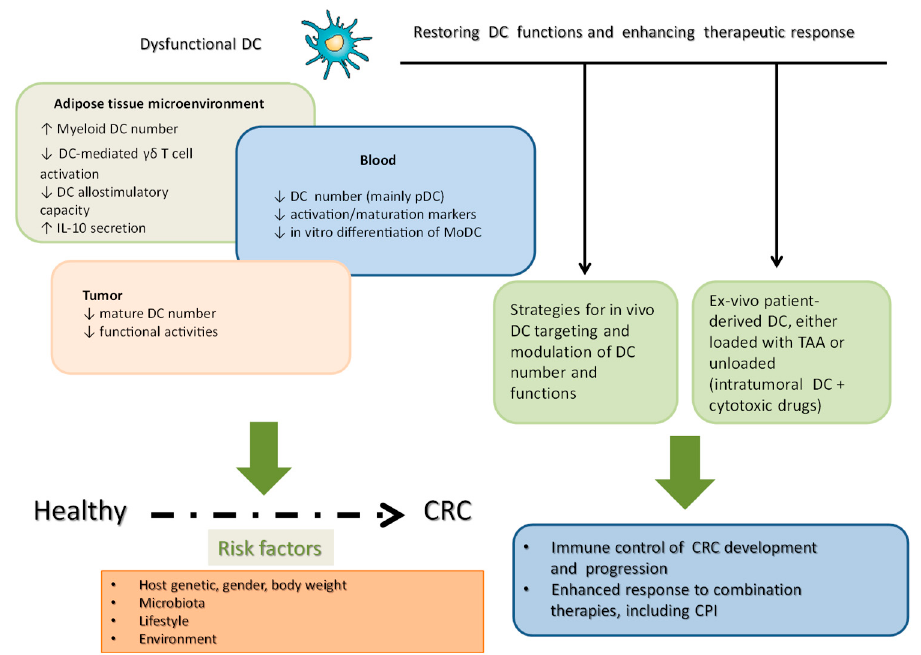
Figure 1. A schematic representation of the main DC dysfunction in adipose tissue, peripheral blood and tumor tissue highlighting the main strategies to restore DC functions and to enhance anticancer immune response.